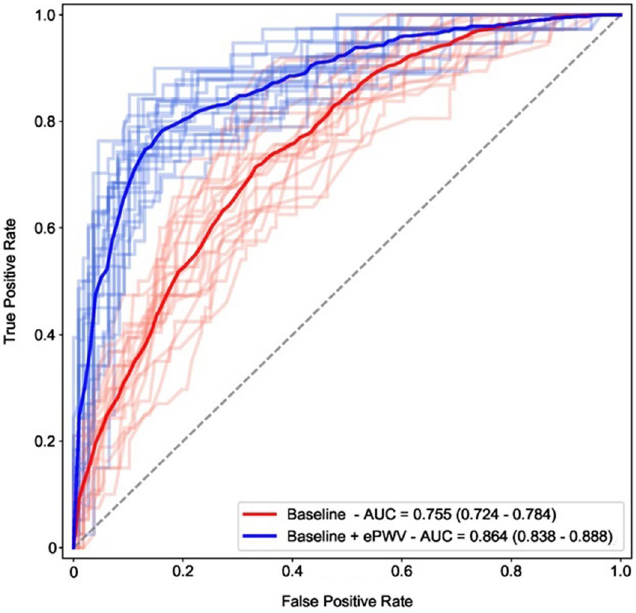
Figure 2. Receiver Operating Characteristic (ROC) curves and corresponding areas under the ROC curve for ePWV on top of the baseline model with respect to 28-day death. Areas under the curve were derived from an appropriate test set (20% of the total sample) after 1,000 bootstrap replicates and training of the boost gradient algorithm on the remaining 80% of the population (training set). Baseline model included age, sex, history of hypertension, DM, CKD, CVD, lung disease and active cancer. To enhance visual clarity a limited number of bootstrapped ROC curves are provided in pale colors as opposed to intense blue and red average estimates.